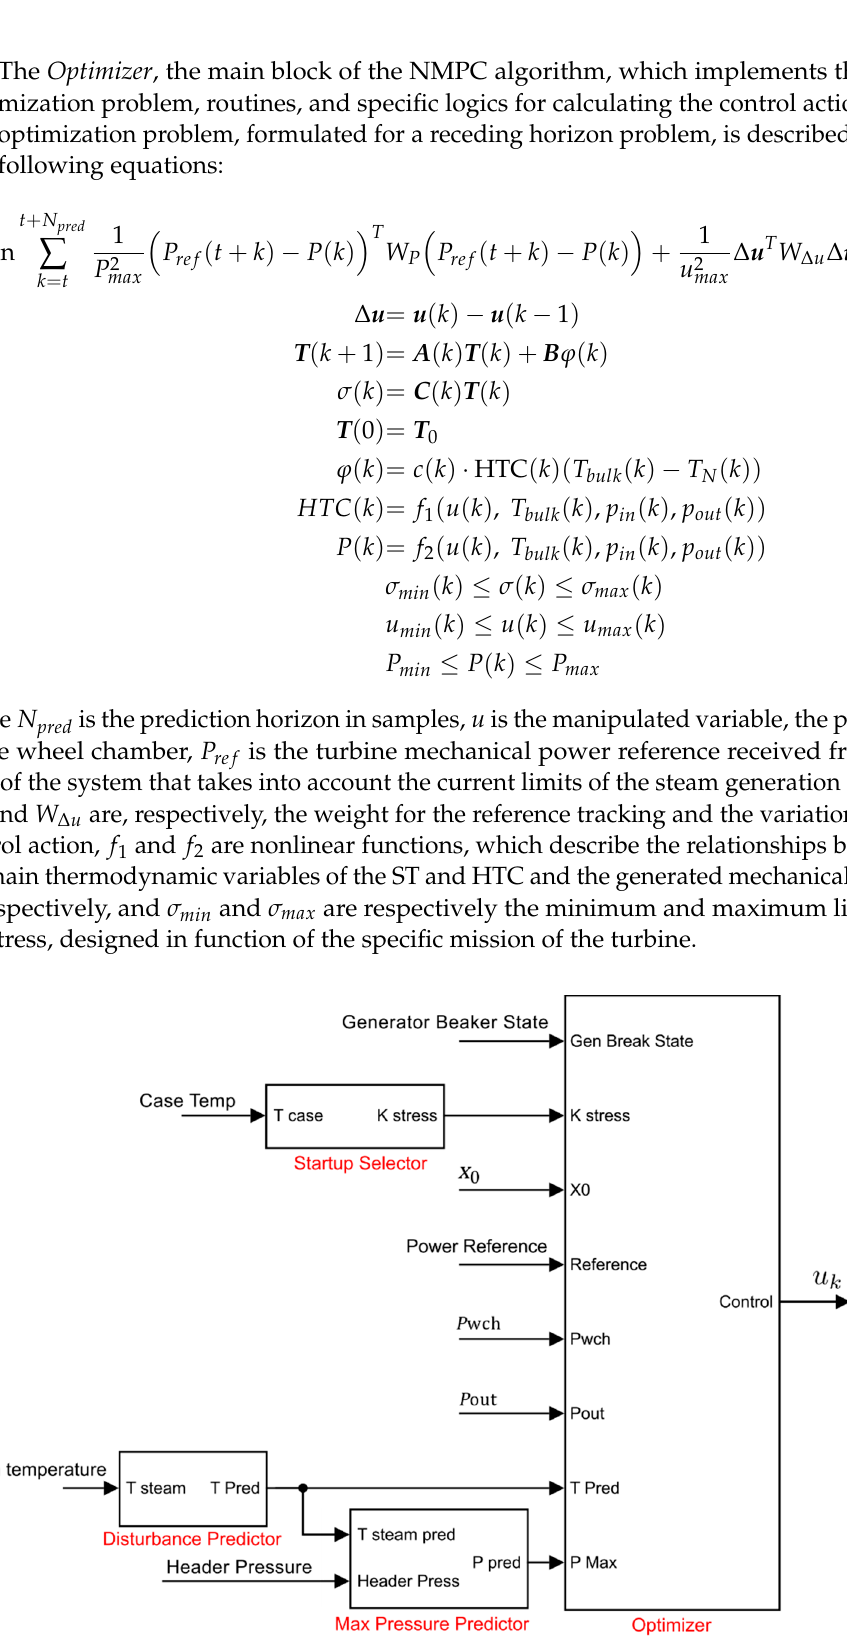
Figure 8. Structure of the Nonlinear model predictive controller.